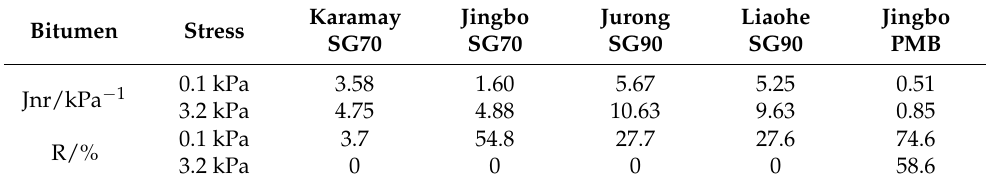
Table 6. The non-recoverable compliance (Jnr) and %recovery (R) tested at 70 ◦ C. Bitumen Stress